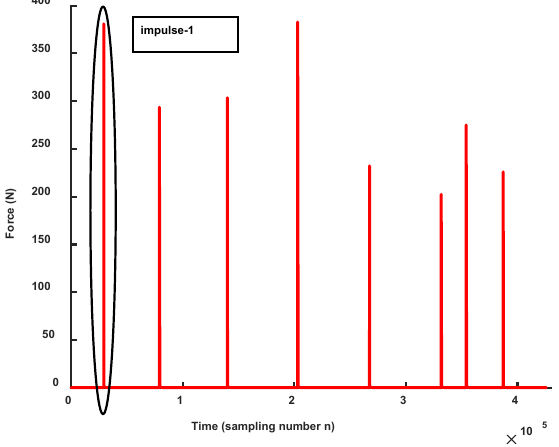
Figure 7. Load-time history of all impact signals.